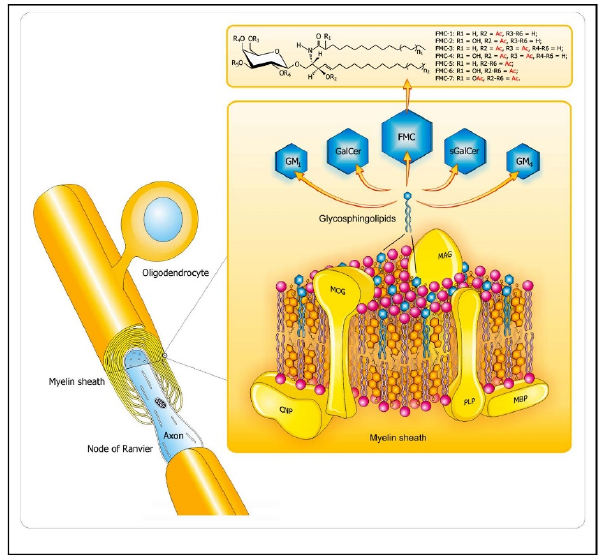
Figure 2. Lipid distribution in the CNS myelin sheaths. The diagram depicts arrangement of complex lipids (cholesterol, phospholipids, and glycosphingolipids) within the most abundant proteins (PLP, MBP) in CNS myelin. The relative molar constancy of lipids: cholesterol/phospholipids (PLs)/galactosylceramide (GalCer) is 2:2:1. Proteins are marked in yellow, and the comprising lipids are as follows: cholesterol in orange, PLs in pink, and the glycosphingolipids (FMC, fast migrating cerebrosides; GalCer, galactosylceramide; GM 1 , mono- sialoganglioside; GM 4 , sialosyl-galactosylceramide; sGalCer, sulfatide) in blue. Structures of unique sphingosine 3-O-acetylated-GalCer glycolipid series, namely, acetyl-cerebrosides (FMCs) are shown at the top. Abbreviations: CNP—2 ′ 3 ′ -cyclic-nucleotide 3 ′ -phospodiesterase, MAG—myelin- associated glycoprotein, MBP—myelin basic protein, MOG—myelin oligodendrocyte glycoprotein, PLP—proteolipid protein. Adapted from [5].